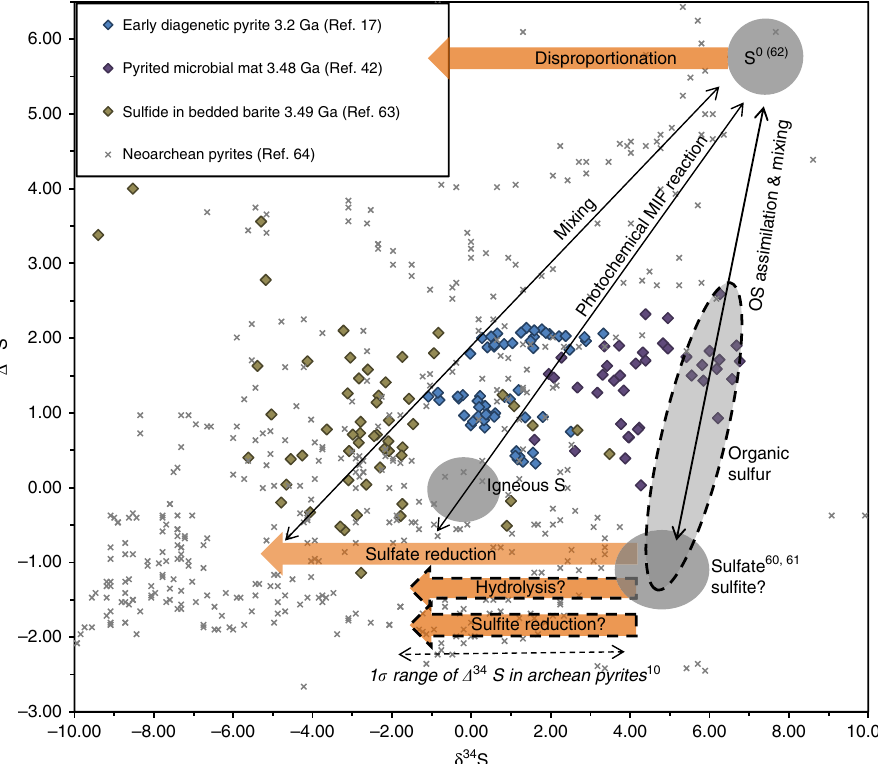
Fig. 3 Summary of potential effects of organic sulfur reactions on the isotopic signatures in Archean pyrites. Symbols illustrate the isotopic data from the literature 10,17,42,60 – 64 for early (pre-oxygenation) Archean pyrites (blue and purple), Neoarchean pyrites (gray), and sul fi de inclusions in sulfate minerals (brown). Gray ovals represent isotopic endmembers; orange arrows denote fractionation-generating microbial reactions. Dashed outlines mark the uncertain contributions and ranges associated with organic sulfur (OS)-speci fi c effects. The poorly constrained Δ 33 S/ δ 34 S composition of the OS pool is plotted here along the sulfate-S 0 mixing line to indicate the possibility of Archean organisms assimilating sulfur from either the seawater sulfate (or sul fi te) or atmospherically derived elemental sulfur endmembers. Increased sulfate reduction induced by the Neoarchean ocean oxygenation would be expected to increase Δ 34 S, as sulfate reduction produces stronger isotopic fractionations than OS hydrolysis, reduction of sul fi te, or S disproportionation. Errors associated with the data points can be found in the original publications (refs. 10,17,42,60 – 64 ) from which the data were